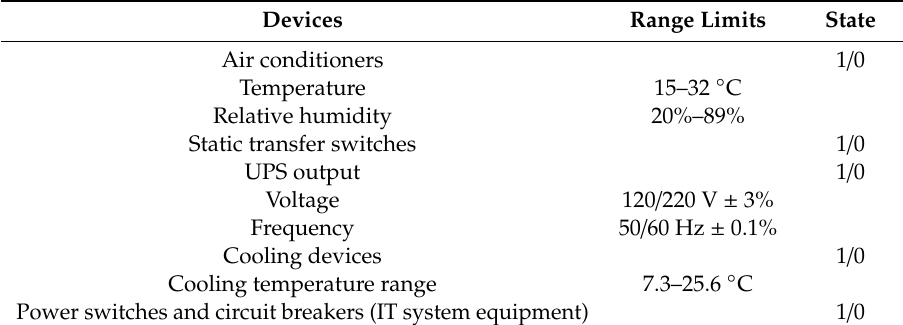
Table 2. Device state detection (1, on; 0, o ff )